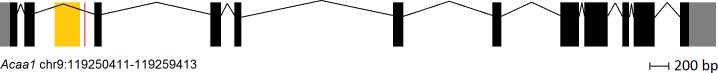
Location of differentially methylated CpG position in of Acaa1 gene.Bars denote Acaa1 exons, lines denote introns, grey bars denote untranslated regions, and black bars denote coding sequence. Yellow bar shows location of DMR from microarray. Red line shows location of 3.2% decrease in methylation at cytosine in CpG site in ethanol-exposed mice (Student’s t-test). Not pictured an additional DMR 3.7 kb upstream, 1.2 kb in size.